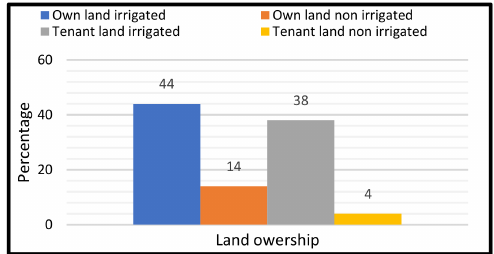
Figure 13. Vegetable seeds farming land details.